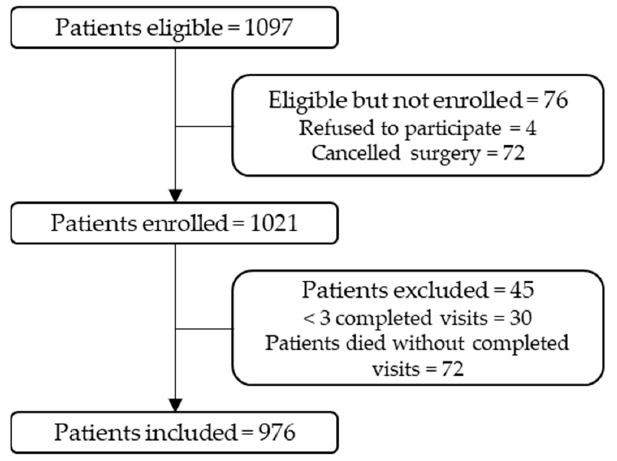
Figure 1. Flow Chart.